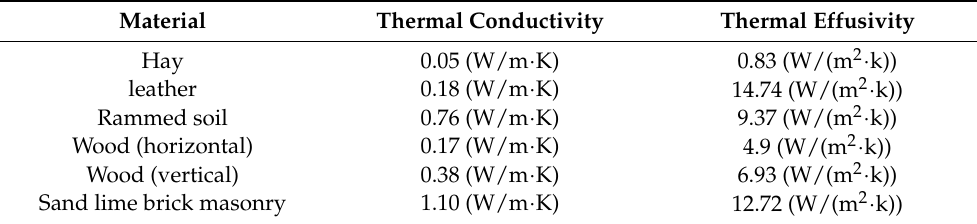
Table 3. Building material thermal coefficient index.